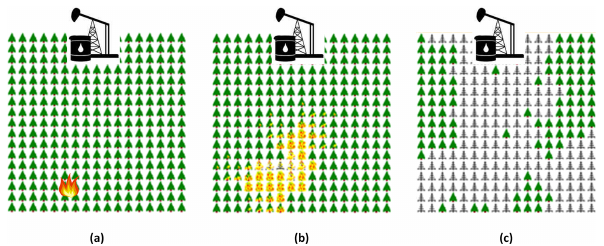
Figure 7. Different zones of a wildfire (adapted from Wikipedia).